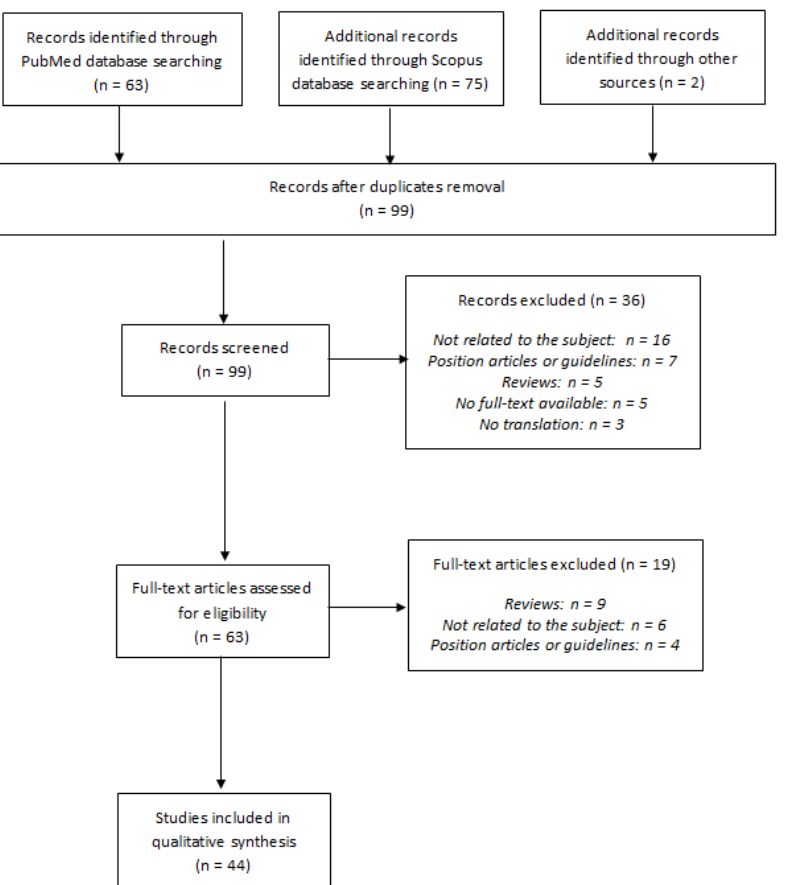
Figure 1. Literature search and selection flow chart according to PRISMA statement.